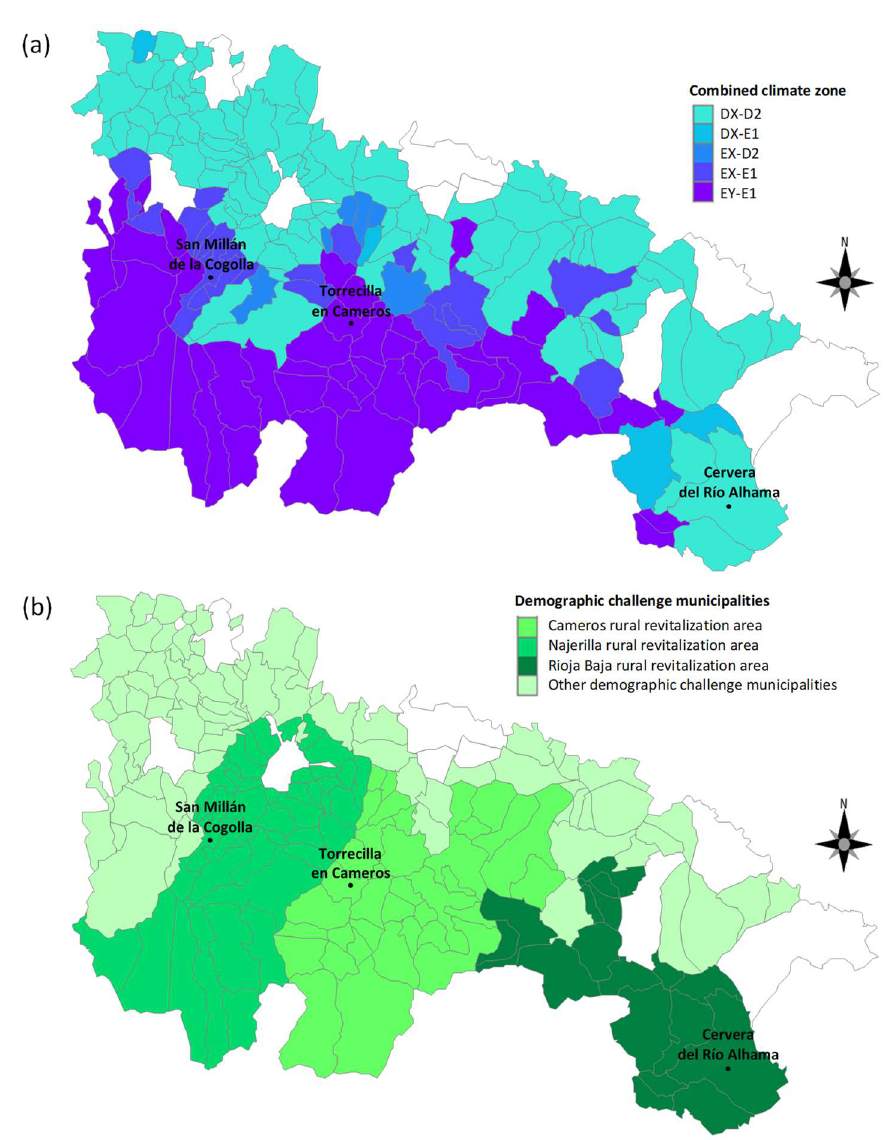
Figure 1. Map of La Rioja: ( a ) the CCZs of the rural municipalities; ( b ) the demographic challenge municipalities.